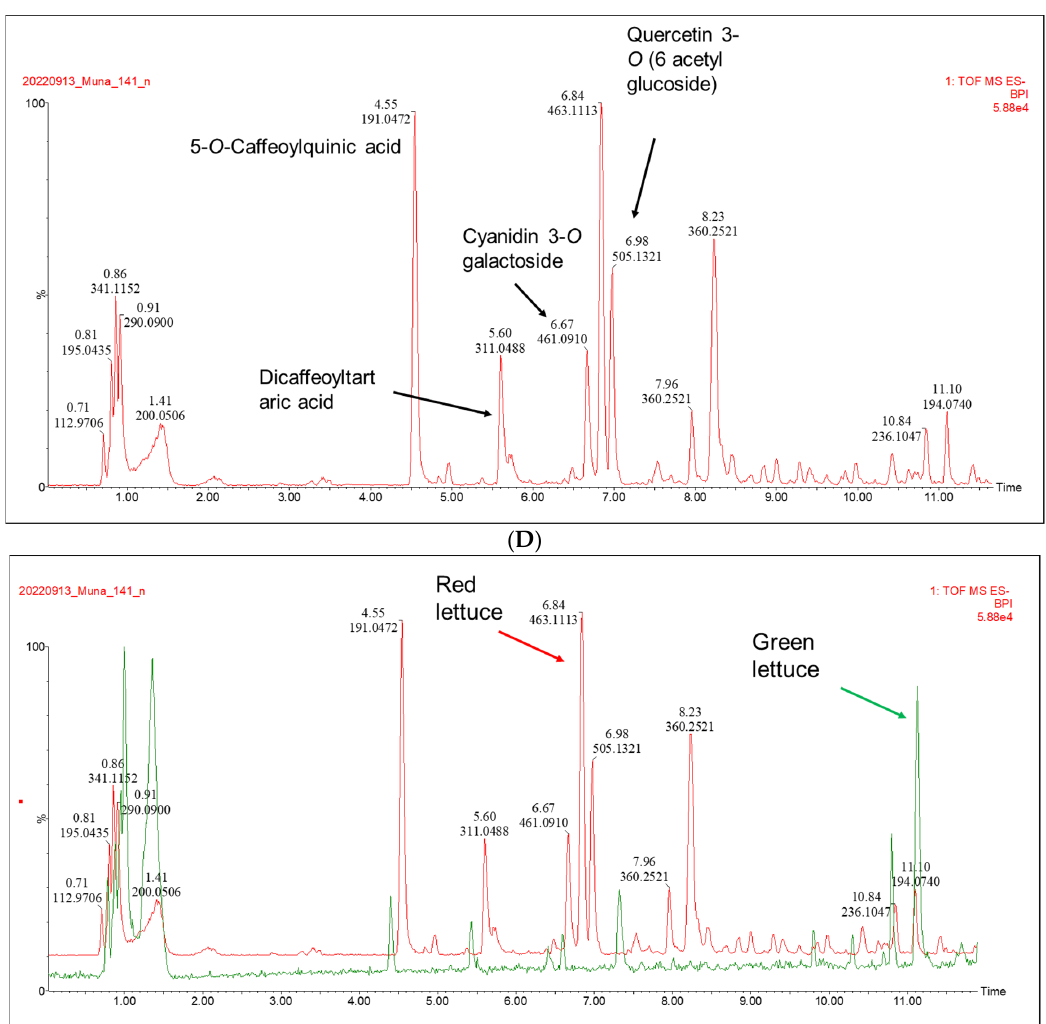
Figure 2. ESI negative mass spectra of ( A ) dicaffeoyltartaric acid (473.0983 m / z; [M − H] − ) in green lettuce; ( B ) 5- O -caffeoylquinic acid (353.0946 m / z; [M − H] − ) and ( C ) cyanidin 3- O- galactoside (447.1095 m / z; [M − H] − ) in red lettuce. ( D ) Base UPLC peak ion (BPI) chromatograms showing selected metabolites from red lettuce under higher Se and S conditions. ( E ) Overlay of BPI chromatograms from green (green trace) and red lettuce (red trace) under higher Se and S conditions. Table 1. Tentative identification of the metabolites in green and red multi-leaf lettuce grown under Se and S treatment using UPLC-HRMS.